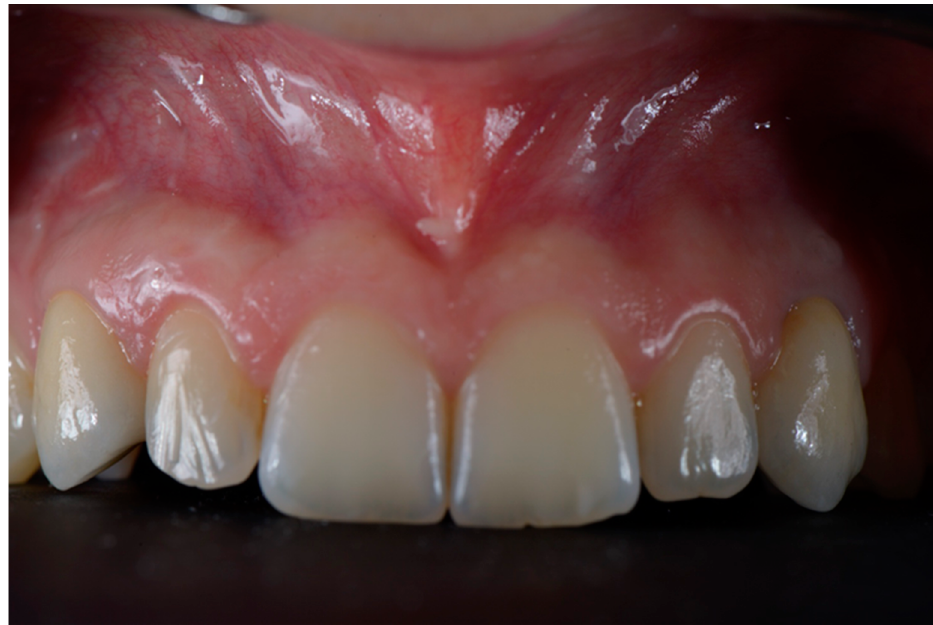
Figure 7. Definitive restorations after 2-year follow-up.